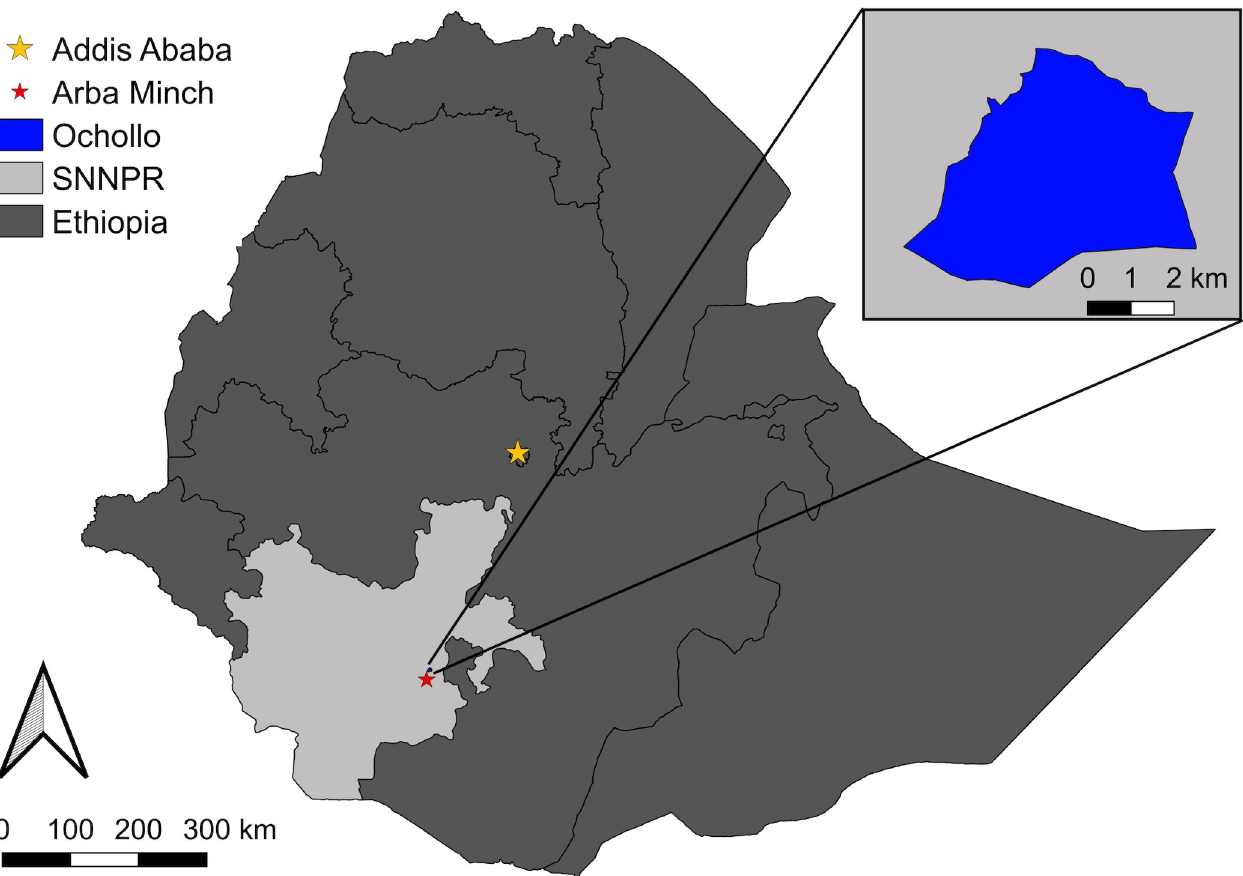
Fig 1. Map of the location of the study site, Ochollo, in Ethiopia [20,21]. SNNPR: Southern Nations, Nationalities and People’s